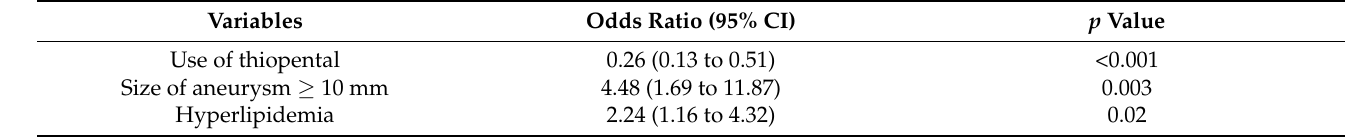
Table 4. Multivariate logistic regression analysis of risk factors for postoperative neurological